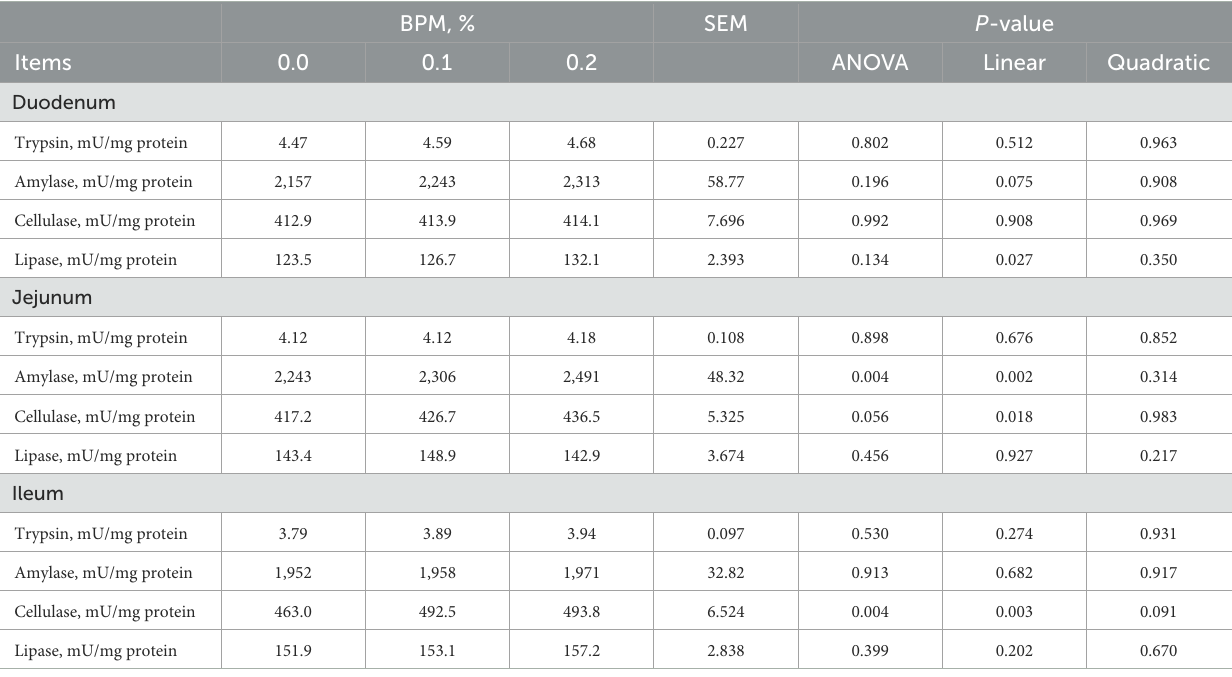
TABLE 7 Effect of dietary supplementation of Bacillus subtilis and Pichia farinose mixture (BPM) on duodenal, jejunal, and ileal digestive enzymes activities of broiler chicks ∗ . BPM, % SEM P -value